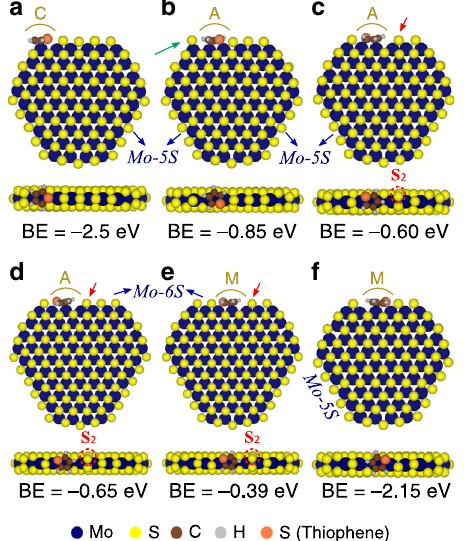
Fig. 4 Thiophene adsorption modes from theory. Top and edge views of calculated minimum energy structures for the adsorption of thiophene on a the corner vacancy, b adjacent vacancy with S atom on the C location shifting from the bridge to top position, c adjacent vacancy with S atom on the M location dimerizing with the neighboring S atom, d adjacent vacancy similar to c but on a longer (six-atoms-long) edge, e middle (M) vacancy with the S atom on the second M location dimerizing with the neighboring S atom on a six-atom-long edge, and f contiguous vacancies on adjacent and middle location. The MoS 2 nanoparticle show different adsorption con fi gurations with their respective adsorption energy. The computed binding energies (BE) are with respect to the corresponding non-rearranged nanoparticle without the adsorbate (and thiophene in the gas phase). That is, the reference particle for a is one with a vacancy at the corner, for b – d is one with a vacancy at the A site, for e is one with a vacancy at the M site and f is one with vacancies at both A and M sites. Red arrows and dashed circles indicate the formation of S-dimers (S 2 ). The green arrow points to the displaced S atom on the corner. Arrows and labels in blue indicate the edge length on the Mo-edge used in the